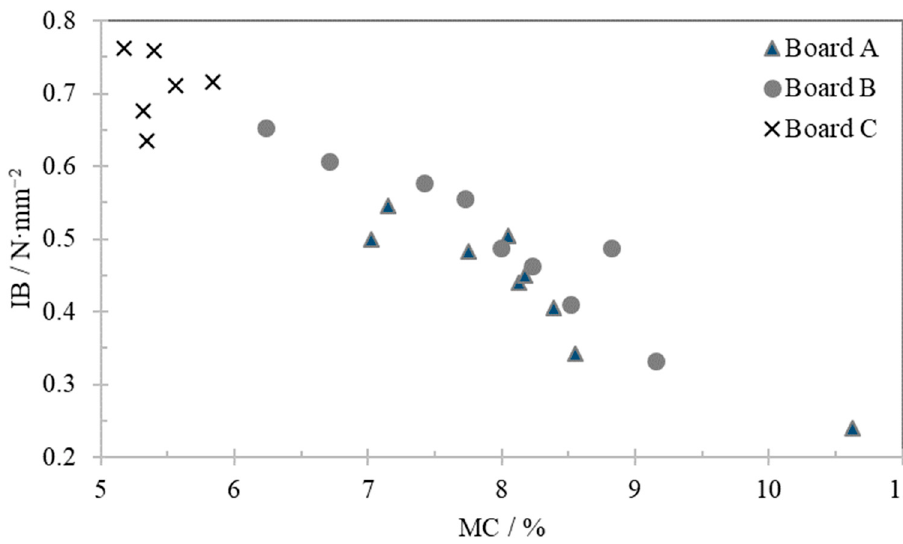
Figure 2. Internal bond dependence on moisture content for samples stored at room temperature and relative humidity.